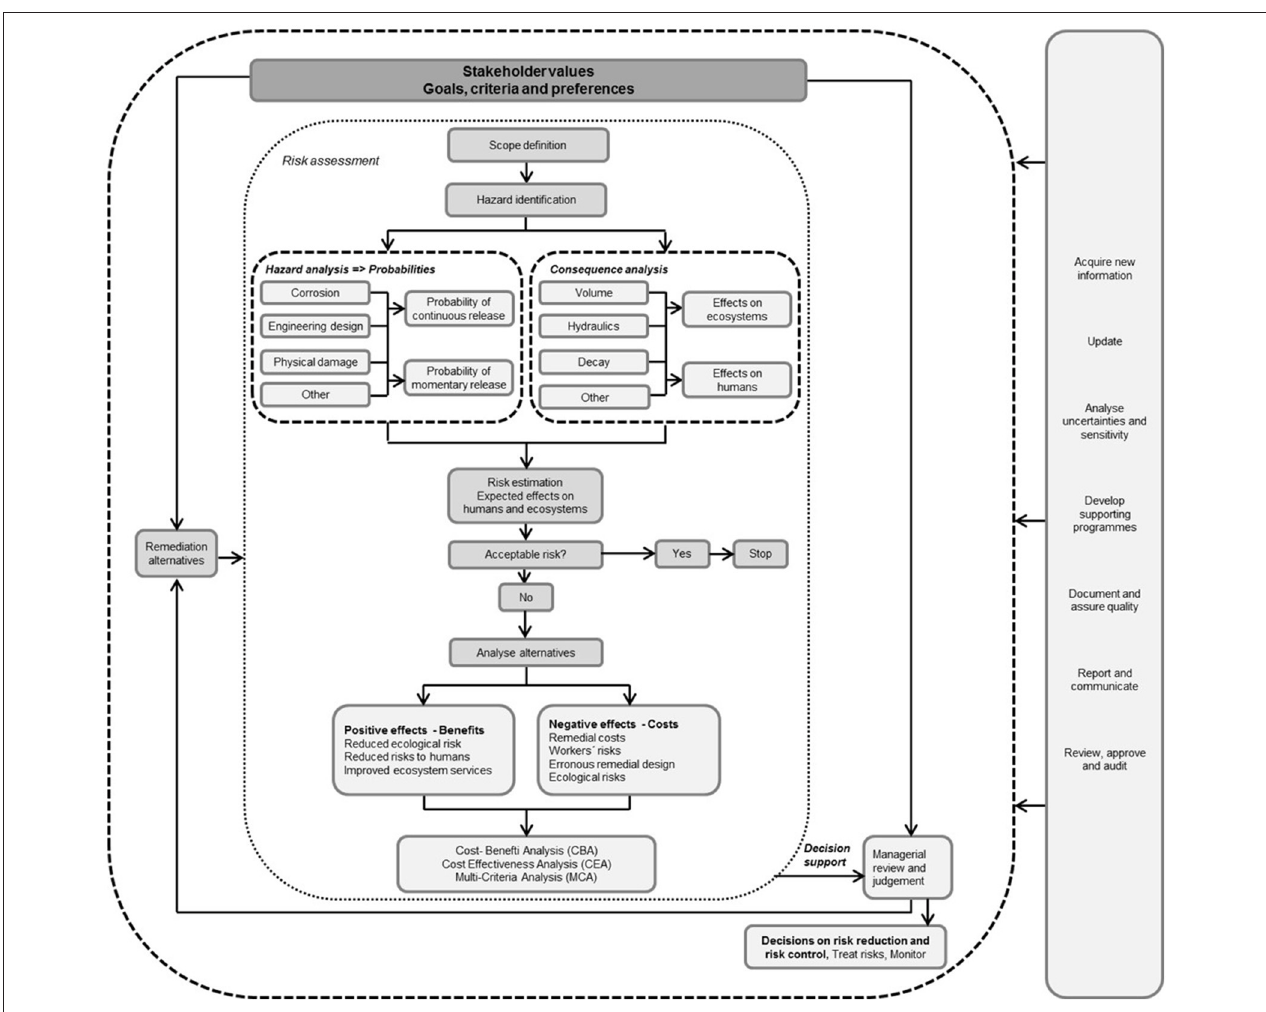
FIGURE 1 | Generic risk management framework for